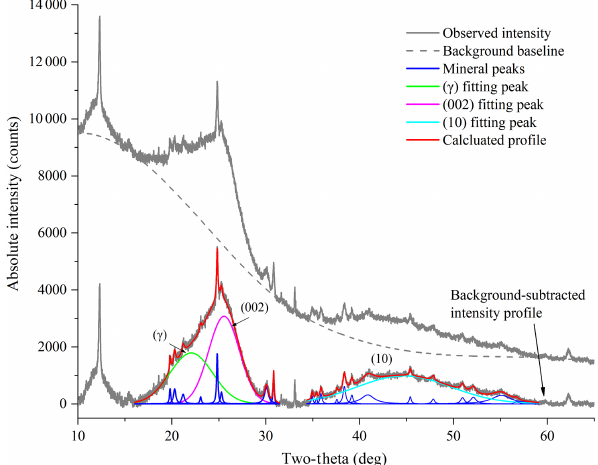
Figure 2. Fitting curves in an X-ray diffraction pattern for sample